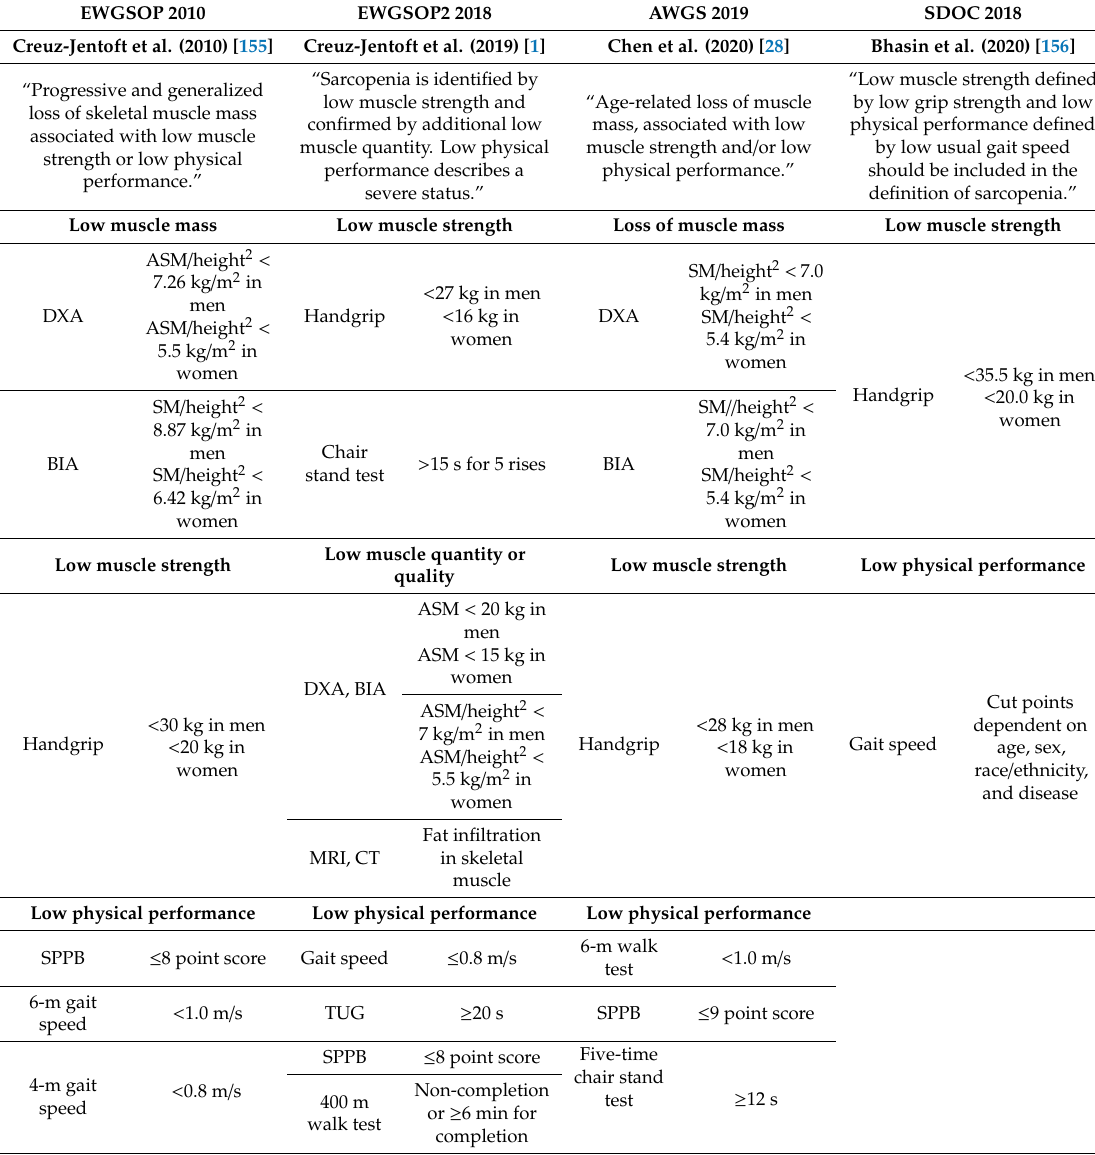
Table 1. Comparison table of major diagnostic criteria and most frequently adopted cut-o ff points for